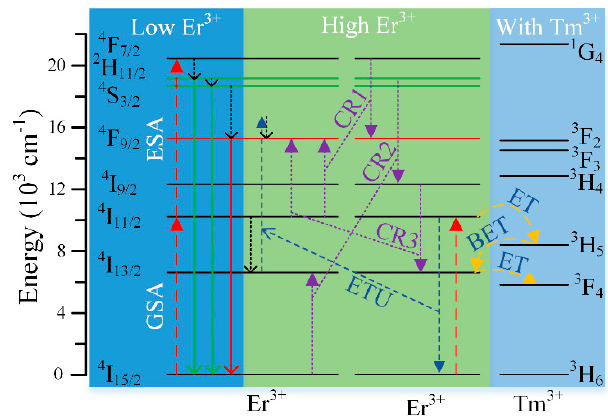
Figure 5. The energy states diagram for Er 3 + and Tm 3 + ions under the excitation of the 980 nm laser. The principle of the ET and BET processes, non-radiative transitions, upconversion luminescence (UCL), energy transfer upconversion (ETU) and CR transitions are also presented in the diagram.